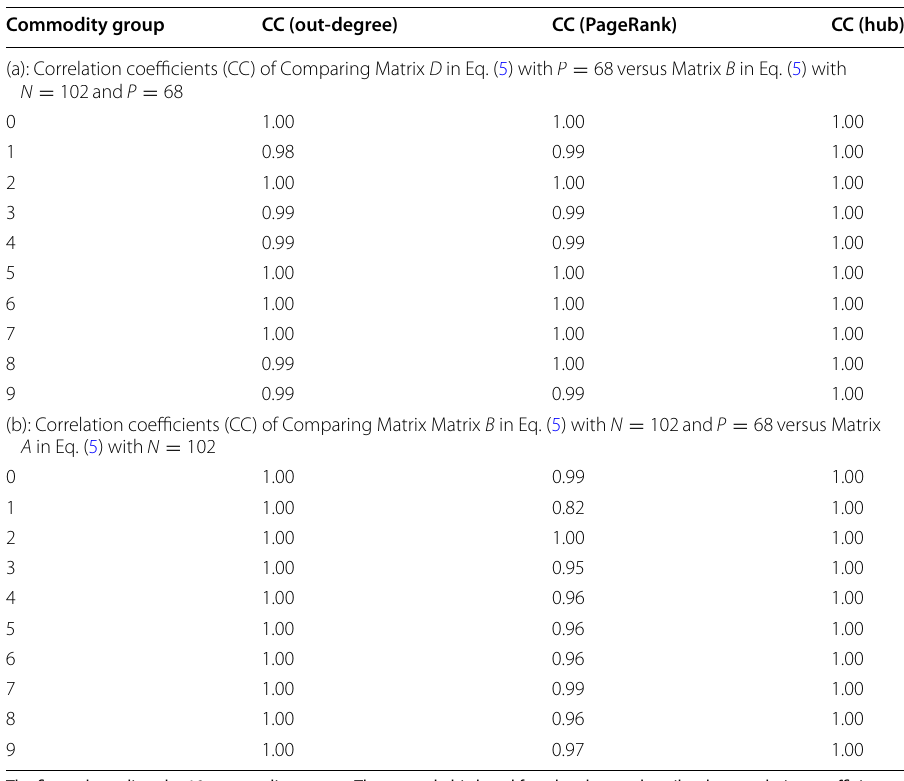
Table 9 Correlation coefficients between the rank of 102 countries in full 102-country network and reduced 102-country network [part (a)], and correlation coefficients between the rank of 68 countries in reduced 102-country network and the 68-country network [part (b)], based on centrality measures in export